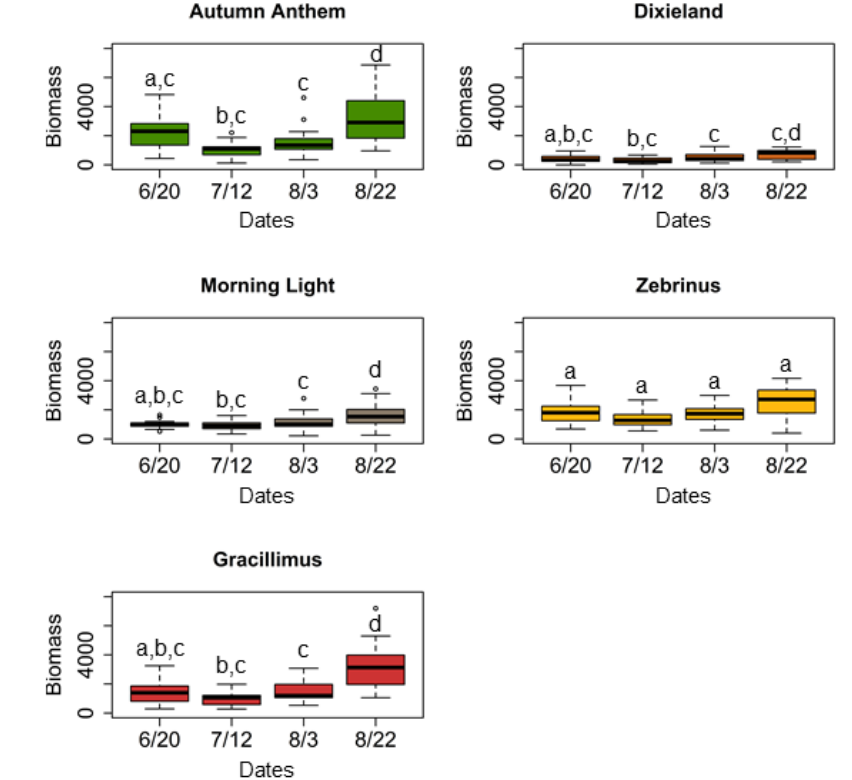
Figure 1. Comparisons of plant biomass changes of M. sinensis cultivars during herbivory assays in the field at the Western Maryland Research and Education Center (Keedysville, MD, USA), across four time points during the growing season in 2018. Box plots represent measurements of the product [height × number of leaves], as a proxy for plant biomass, which was used for comparisons. Data comparisons were conducted using one-way repeated measures analysis of variance (ANOVA); plant biomass changes that do not share a letter is significantly different based on post hoc Tukey’s honestly significant difference (HSD) test (Tukey HSD: p < Table 1. Changes in plant responses to herbivory in five Miscanthus sinensis cultivars during the season June–August 2018 in the field and cage experiments.